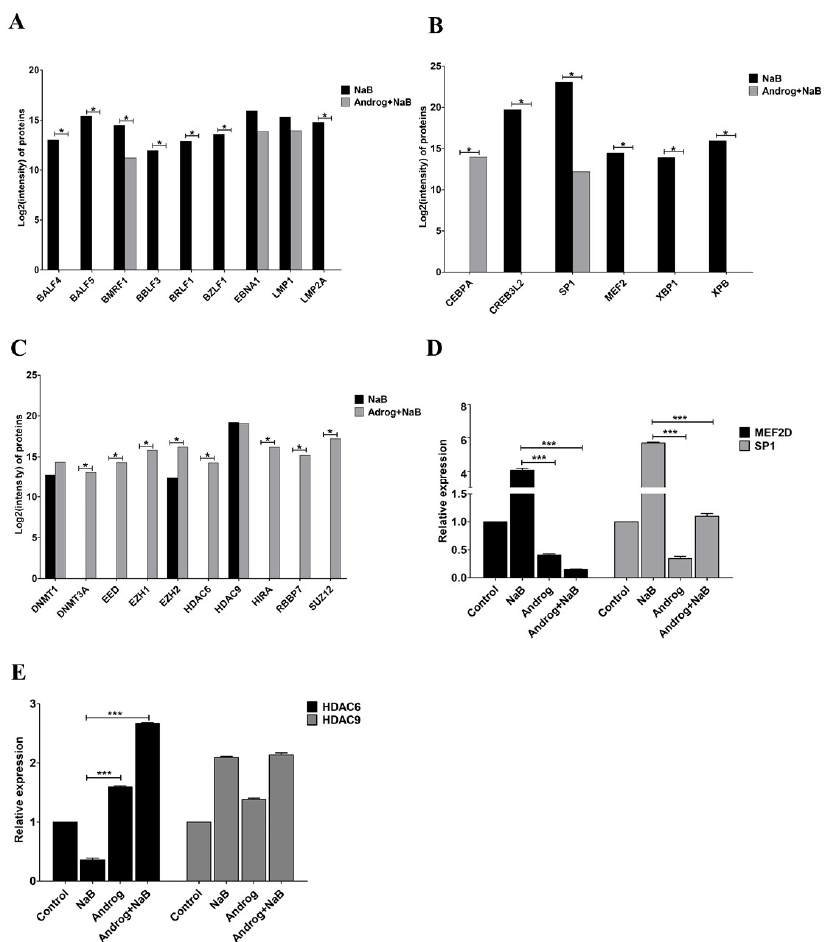
Figure 3. Andrographolide inhibits the expression of EBV lytic protein and host TFs. Cells were either treated with NaB or a combination of andrographolide and NaB, and the expression of EBV lytic genes and host TFs was examined using LC–MS/MS. ( A ) Lytic and latent genes; ( B ) activators; ( C ) suppressors and qRT-PCR; ( D ) MEF2D and SP1 ; ( E ) HDAC6 and HDAC9 . *: p < 0.05 and ***: p < 0.001.